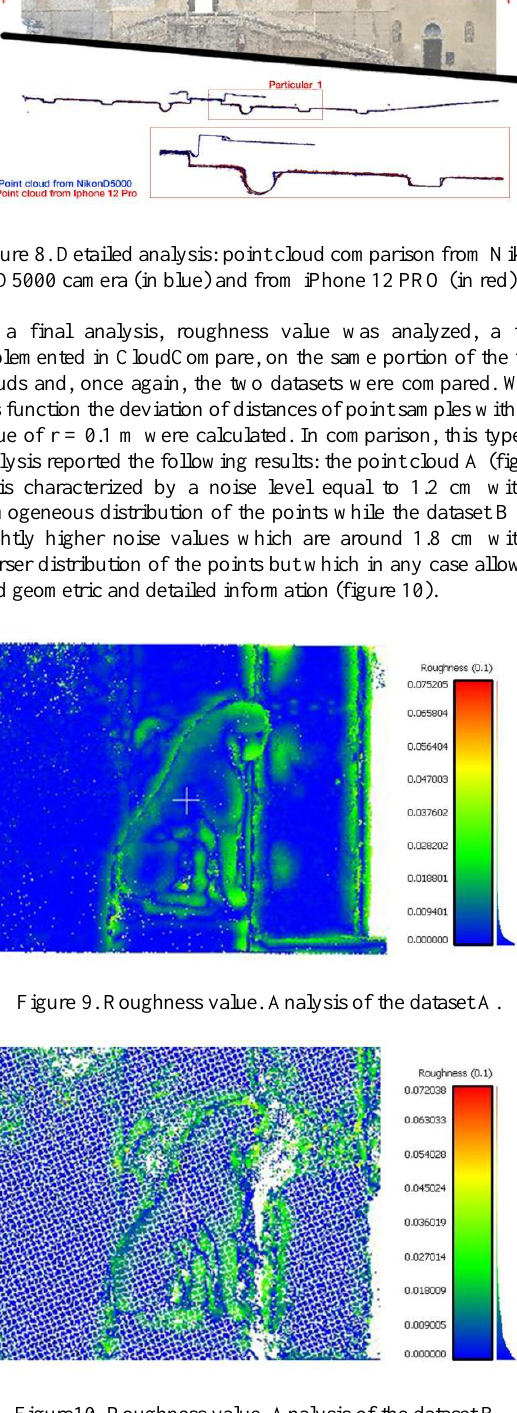
Figure 7. Alignment and calculation of the deviation between point cloud A and B, in Cloud Compare.